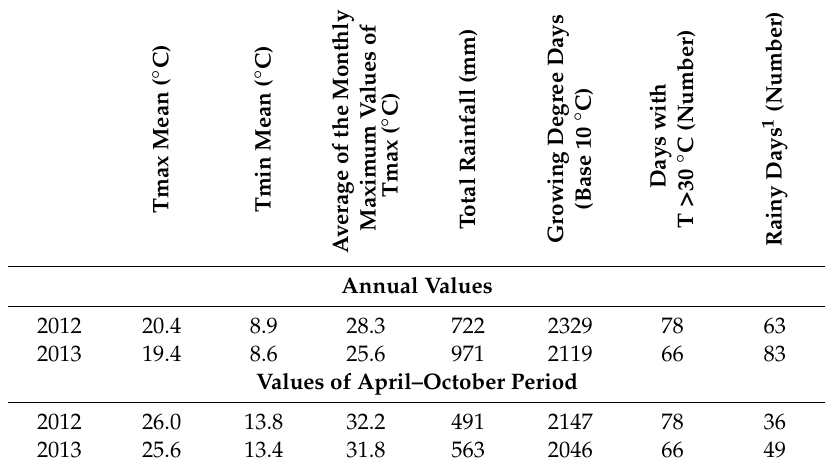
For the same year, means fallowed by different letters are significant different for p < 0.05. ns—not